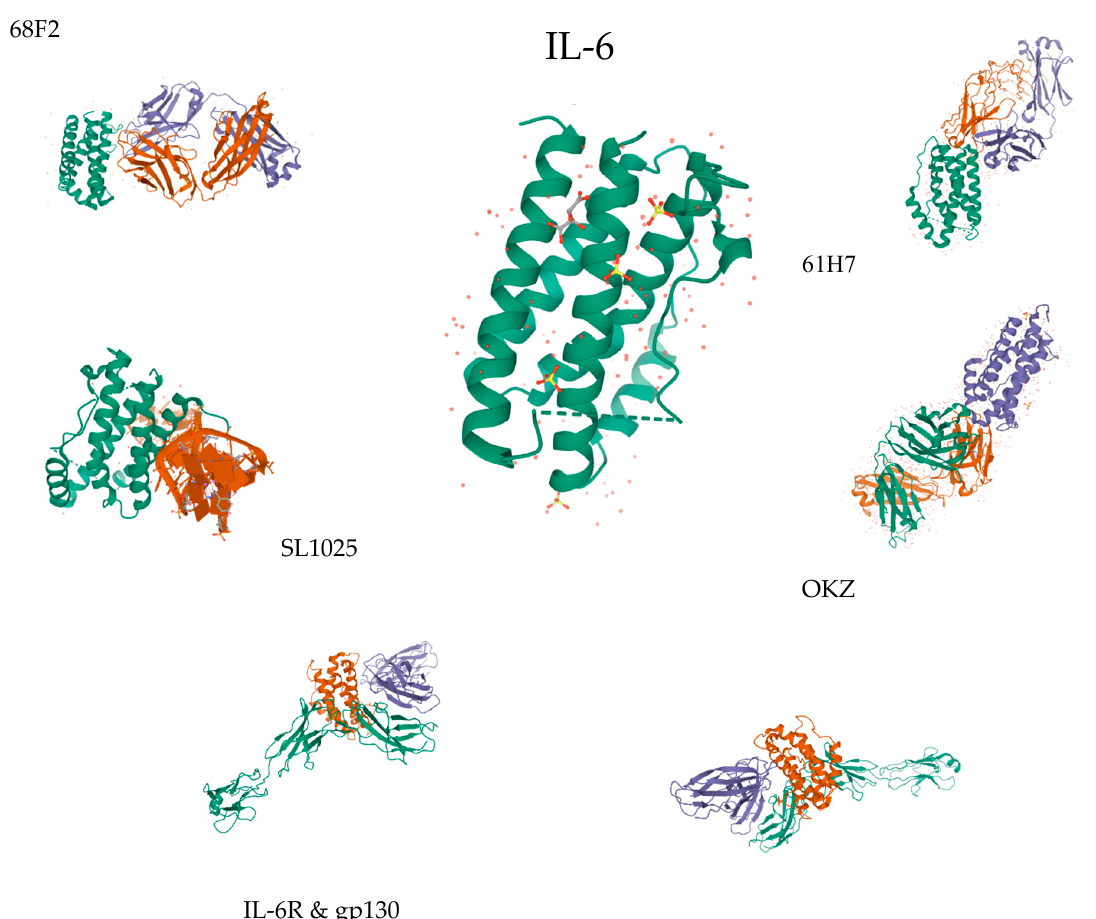
Figure A1. The 3D pictures of IL-6 alone (in the middle) and conjugated with different receptors. The complex IL-6 ∙ gp130 ∙ IL-6R is given in two different orientations (IL-6R in blue and green, gp130 in green). Source: The Protein Data Bank [34].